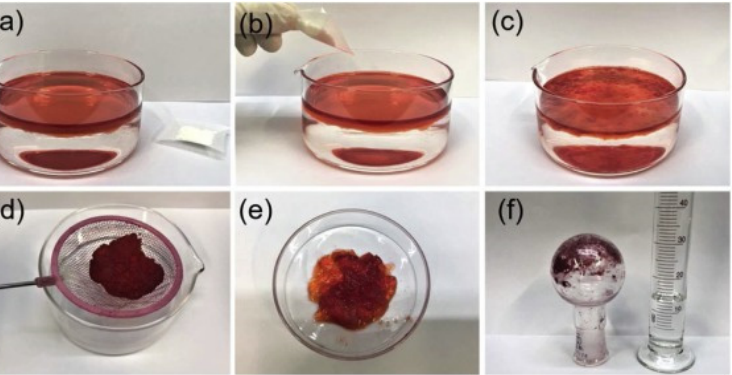
Figure 71. Process of solidifying and removing toluene from an oil-water mixture: ( a ) Aqueous biphasic mixture of toluene, dyed with Disperse Red 152; ( b ) Addition of the powdered gelator; ( c ) Instantaneous gelation of the toluene layer; ( d ) Removal of the solidified toluene layer; ( e ) Toluene gel after removal; ( f ) Graduated cylinder containing the recovered toluene and recovered gelator (separated by vacuum distillation). Reprinted with permission from [72]. Copyright (2020) Elsevier. An arabinopyranoside-based gelator (compound 27b in Figure 19) was used for the phase selective gelation of crude oil and removal of oil from sea water. They showed that the gelator 27b with starch composite (1:1, 500 mg) was able to solidify crude oil layer at room temperature instantly, therefore the crude oil powder can be scooped away from the water mixture. The combination of the gelator and starch causes a uniform dispersion of the gelator throughout the oil layer, leading to fast and uniform gel formation. The starch acts as a solid support for gelator dispersal and minimum gelation concentrations as low as 0.34% w / v were achieved using this method [62]. The results of this study are a significant step towards using LMWGs in solid form for congealing crude oil from bipha- sic oil-water mixtures. Hou et al. examined dibenzylidene acetal protected sorbitol compound 37a depicted in Figure 27, as a LMWG in applications of oil solidification and removal. A wide variety of oils were tested and minimum gelation concentrations of 0.04–0.10 g/mL were ob- served. Gelation was found to occur within 17 min of adding the powdered gelator to the oils [128]. In further studies, they found that the amount of water used in the experiment did not impact gel formation. The results of this study show that dibenzylidene acetal protected sorbitol is an efficient LMWG in oils and has potential for use in marine oil spill cleanup applications. Sureshan et al. designed and synthesized five glucose-derived phase selective or- ganogelators, which can form gels at room temperature when applied as a fine powder. To reduce the water solubility, thioalkyl or thioaryl motifs were installed at the anomeric position of the sugar head group [129]. The resulting compounds were found to selec- tively congeal oils in aqueous biphasic oil solutions. Gelators 118a and 118b (Figure 72) were found to be supergelators in crude oil with minimum gelation concentrations of 0.5